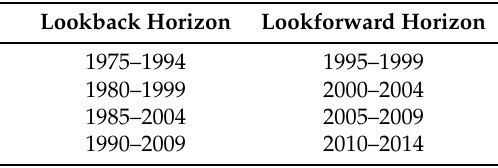
Table 2. Jumping fixed-length horizon backtests data horizon.